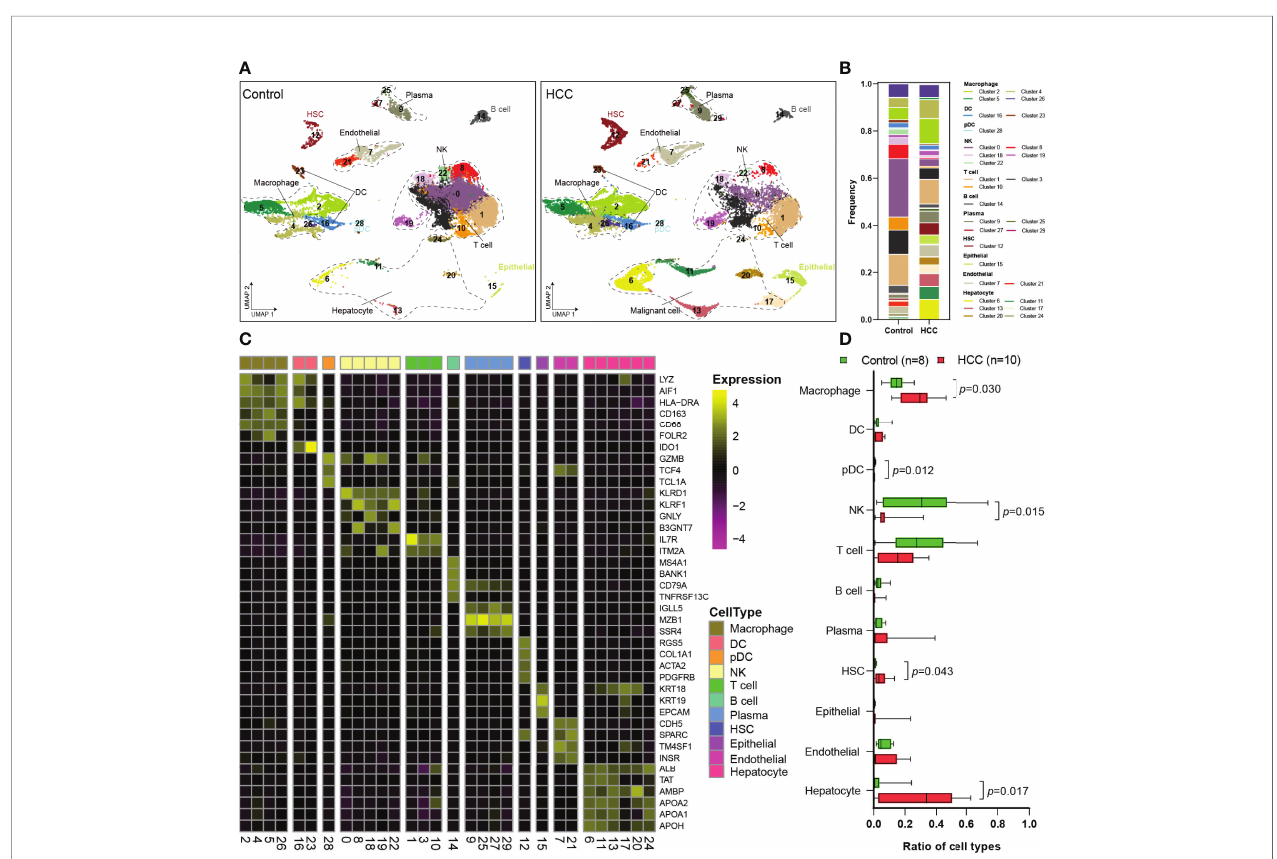
FIGURE 1 | Single-cell atlas of the HCC and tumor-adjacent tissues. (A) Overview of the cell clusters based on scRNA-seq data from tumor-adjacent and HCC tissues (UMAP). (B) The frequency of cells in each cluster. (C) Heatmap showing the expression of marker genes in the indicated cell types. The bottom bars label the clusters corresponding to speci fi c cell types, and the number in brackets corresponds to the cluster number in panel (A, D) Histogram indicating the proportion of cells. HCC, hepatocellular carcinoma; scRNA-seq, single-cell RNA sequencing; UMAP, uniform manifold approximation and